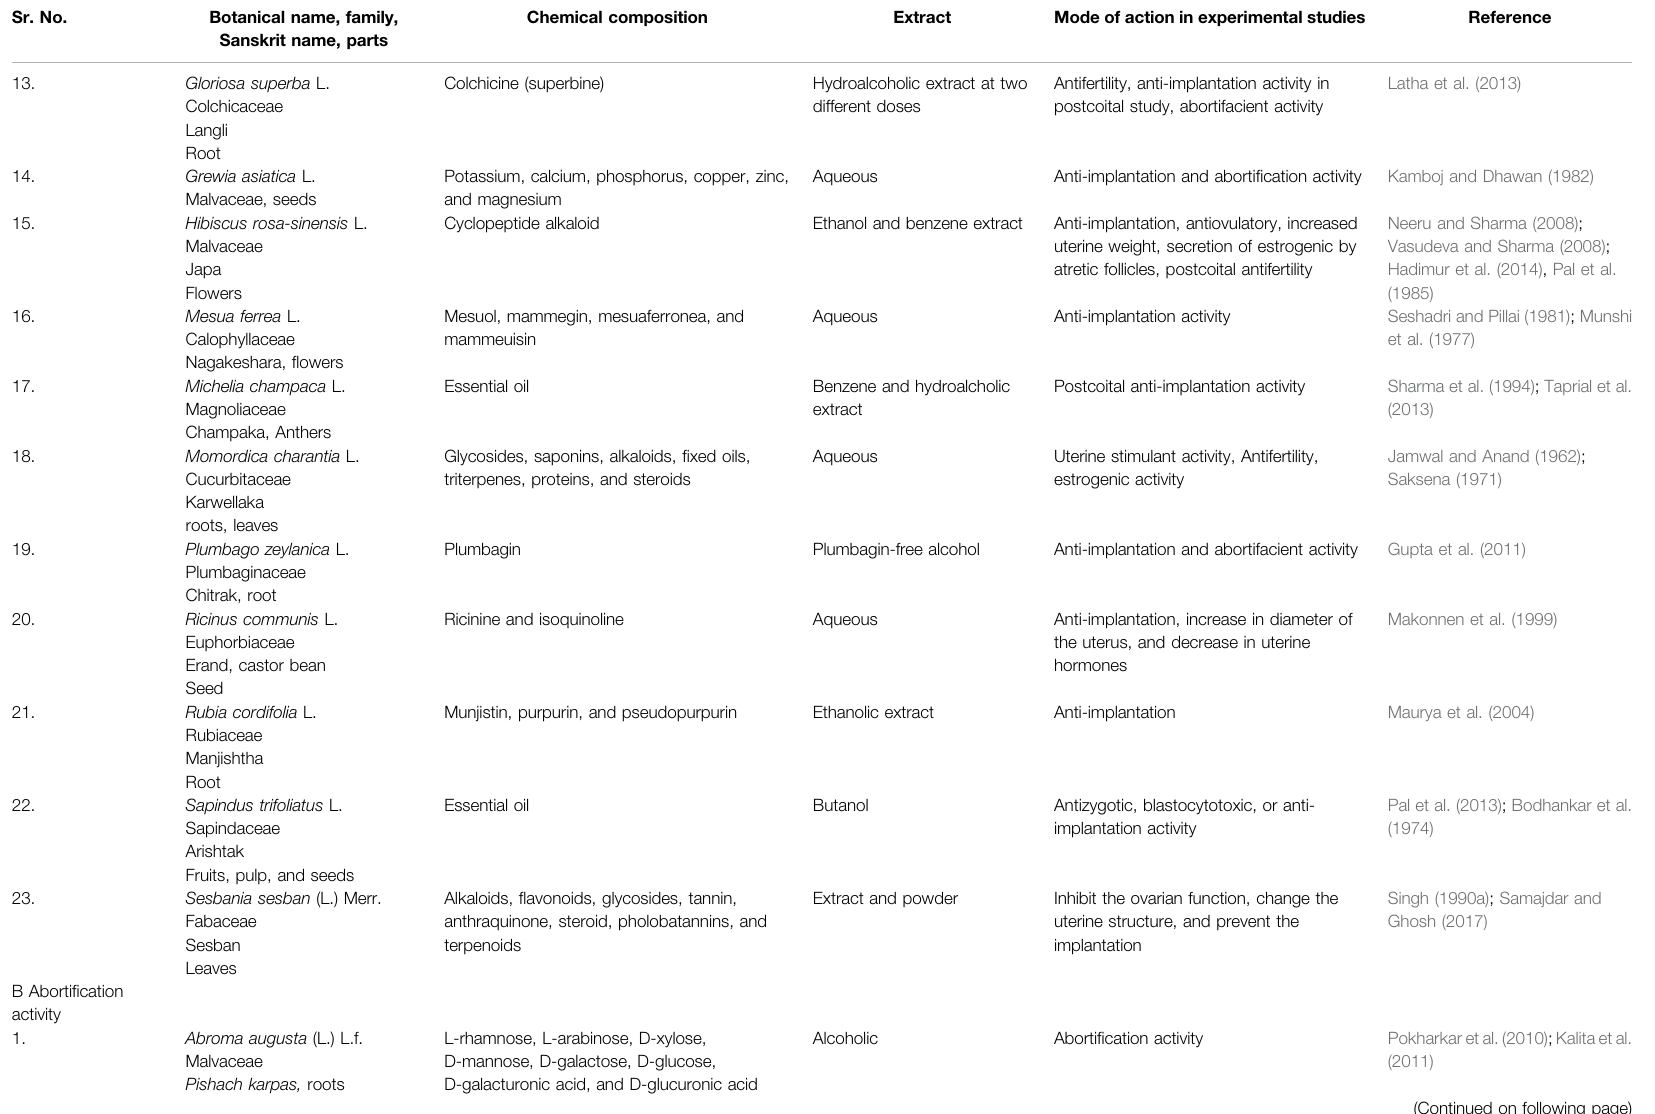
TABLE 2 | ( Continued ) Medicinal plants and their phyotoconstituents validated for various female/male contraceptive activities. Different contraceptive activities studied on medicinal plants could be categorized as follows. Female contraceptive activities: (2A) anti-implantation activity, (2B) aborti fi cation, (2C) antifertility, (2D) antiovulatory, and (2E) antiestrogenic activity. Male contraceptive activities: (2F) antispermatogenic, (2G) spermicidal, and (2H) antiandrogenic